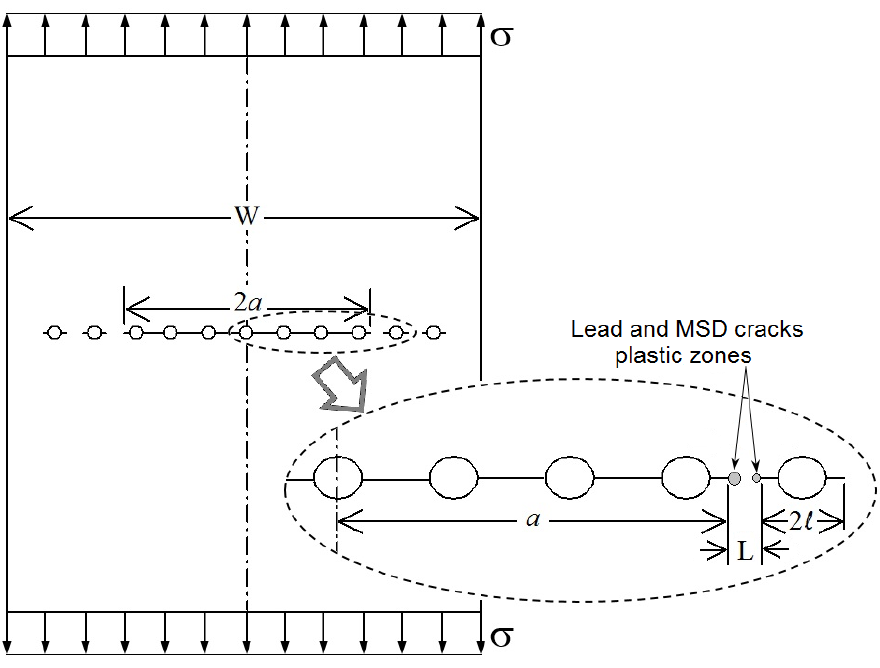
Figure 1. Illustration of the MSD test panel geometry and the crack-tip plastic zone.